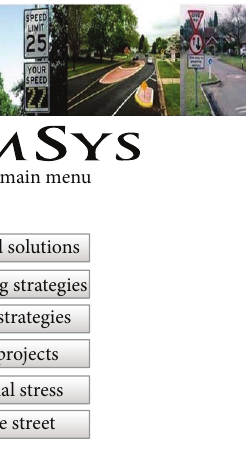
Figure 4: A screenshot of the CALMSYS main